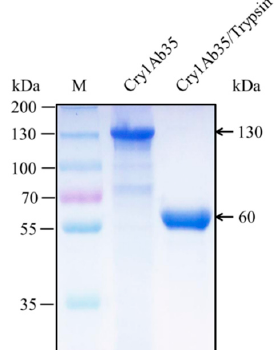
Figure 1. SDS-PAGE (10%) analysis of Cry1Ab35 expressed in B. thuringiensis HD73 − strain and the activated Cry1Ab35 toxin digested by trypsin. Lane M shows molecular weight markers.